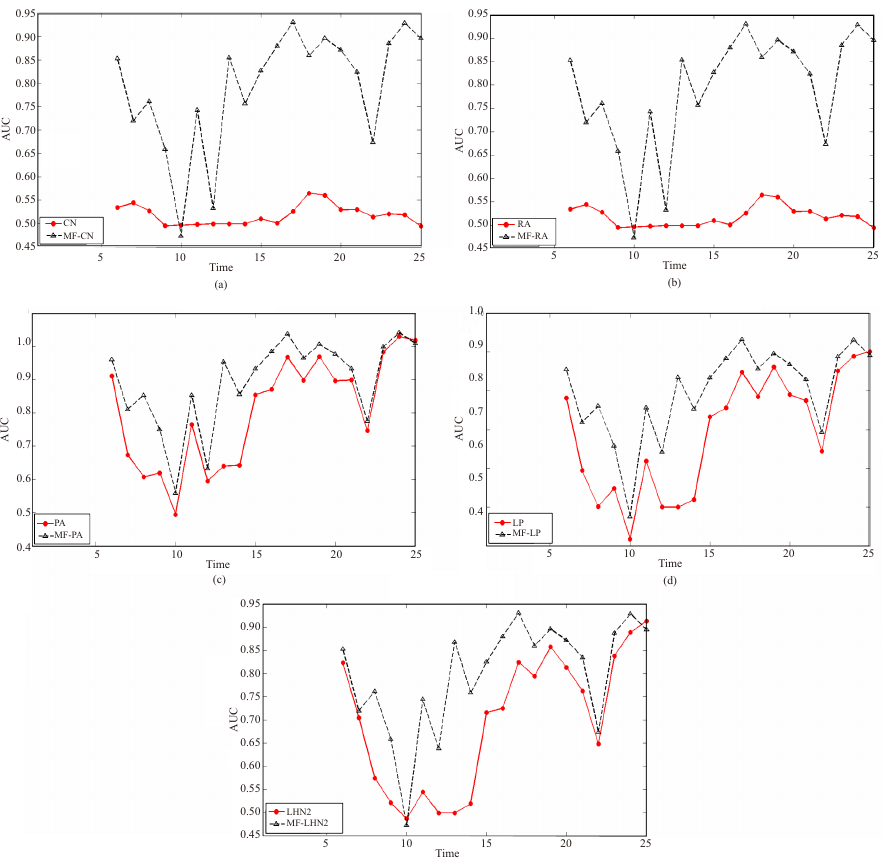
Fig. 3 Performance of different methods on Irvine